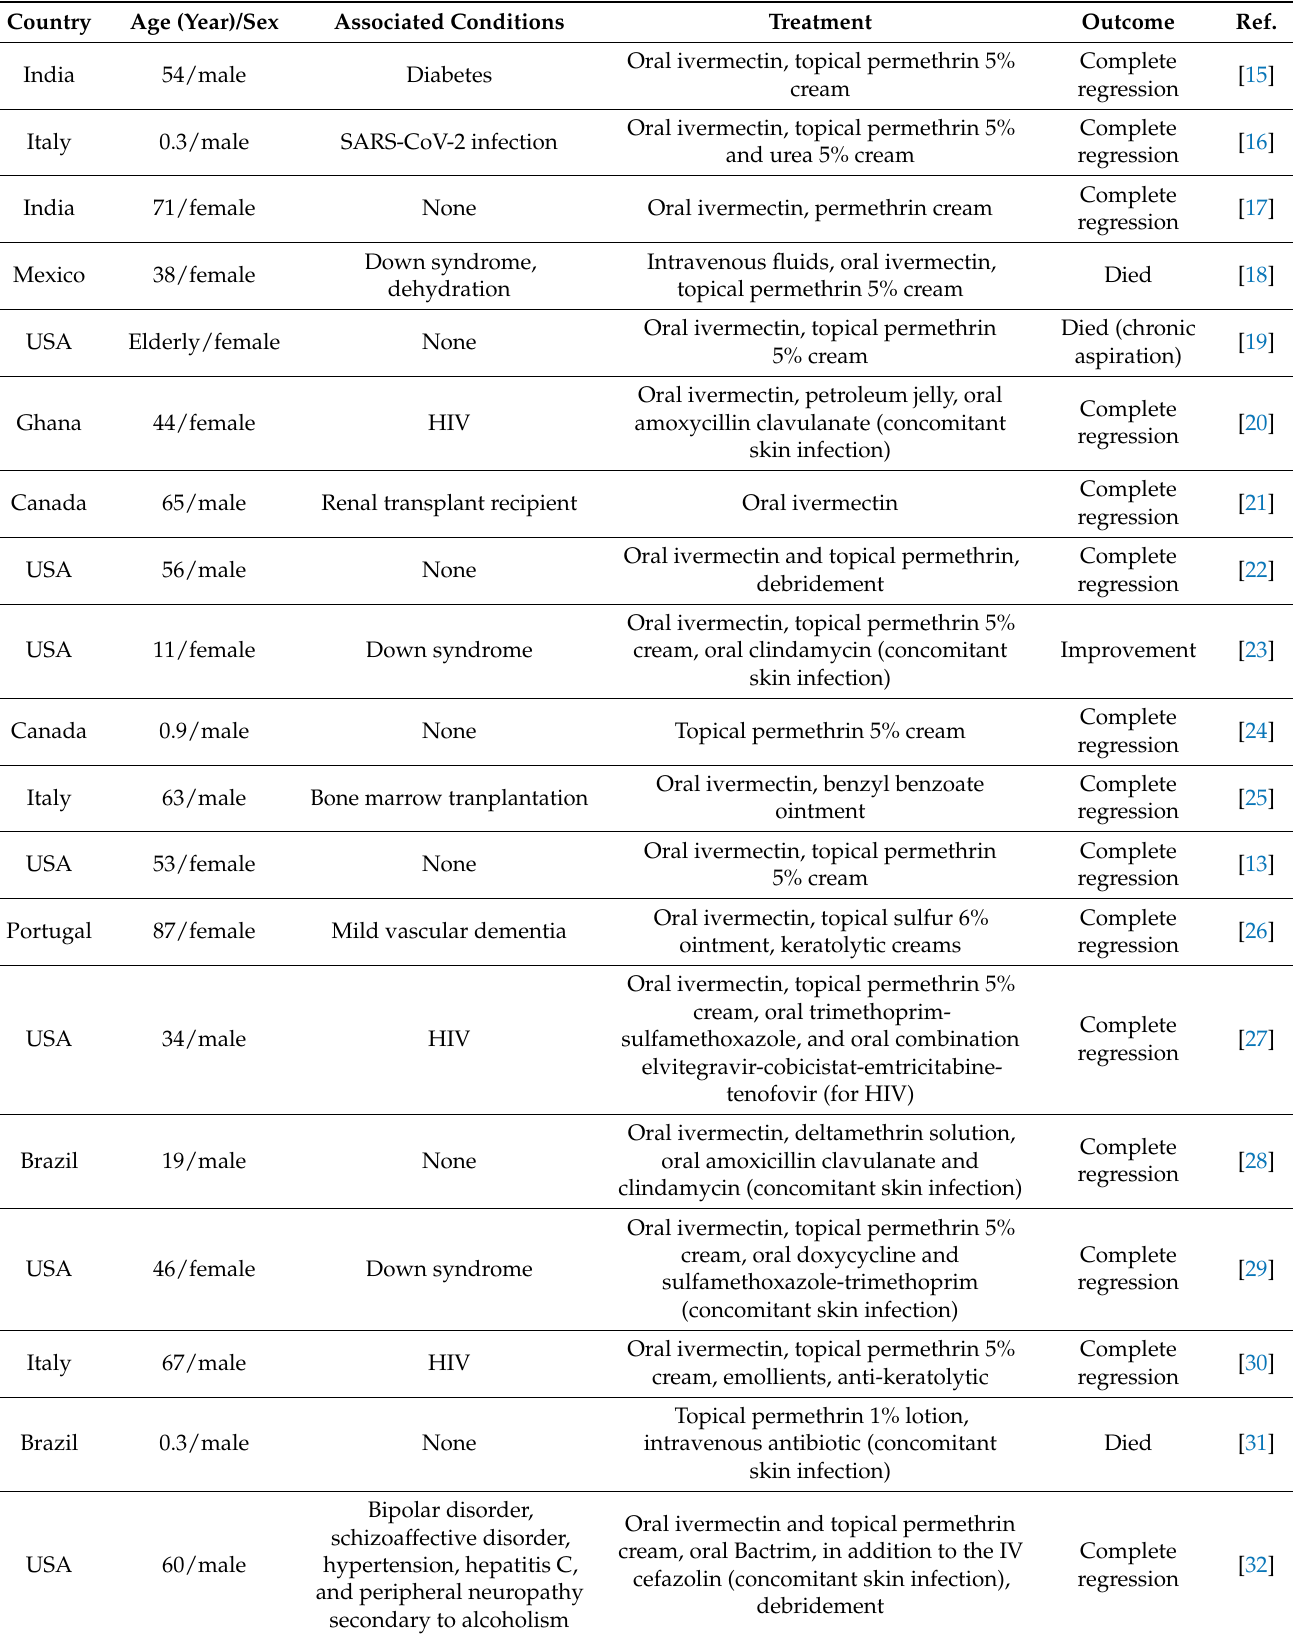
Table 2. Summarized finding from the literature review of crusted